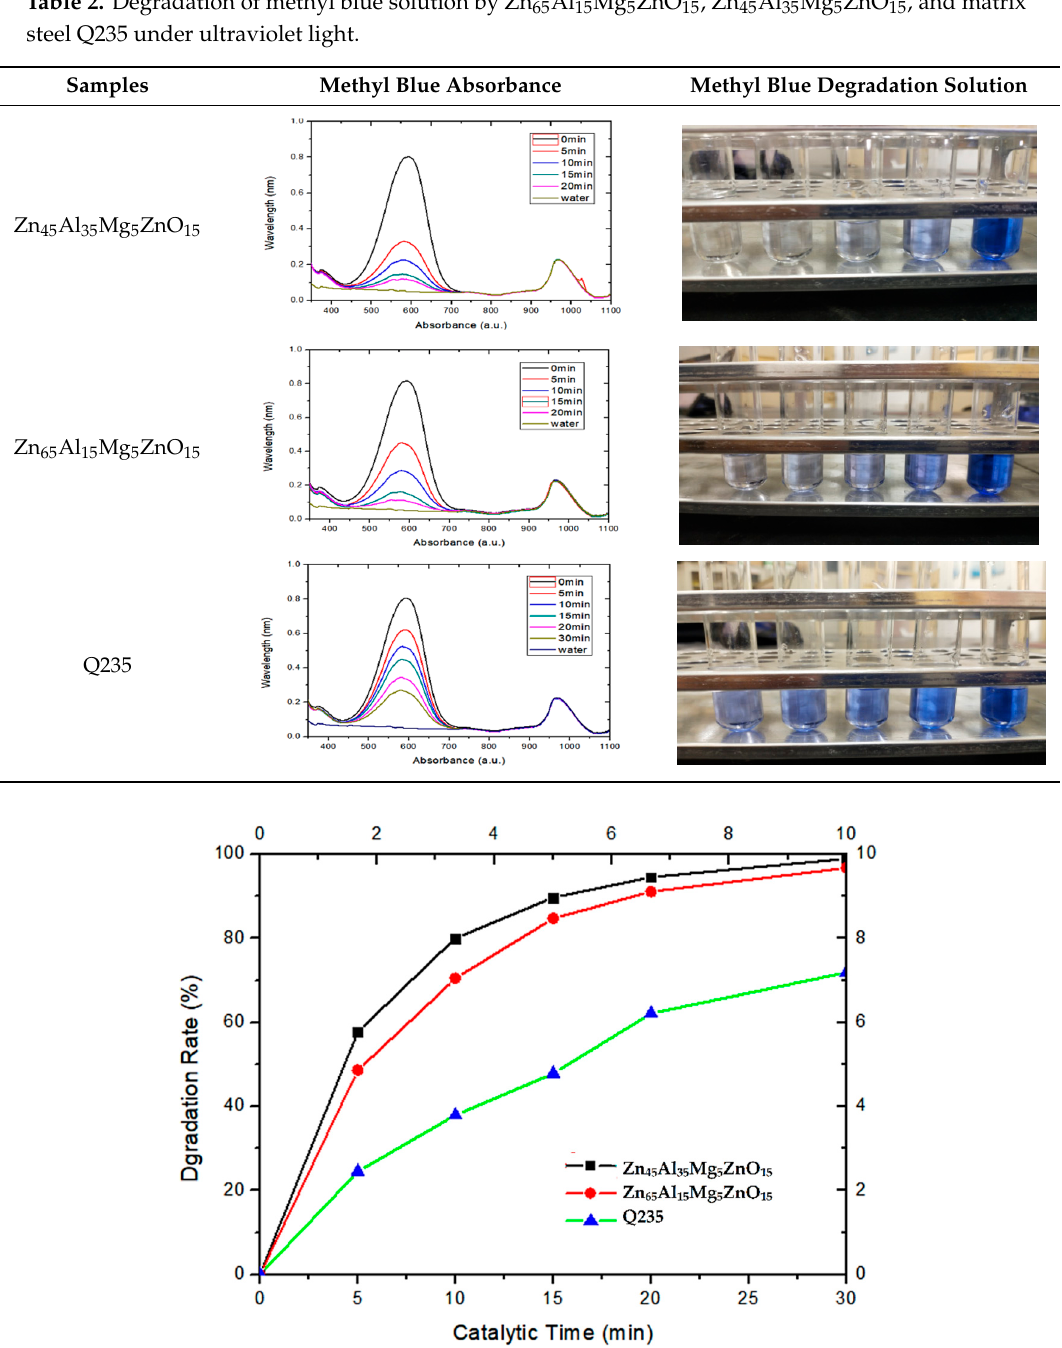
Figure 11. Degradation rate of equivalent concentration of methyl blue under ultraviolet light at di ff erent times for Zn 65 Al 15 Mg 5 ZnO 15 , Zn 45 Al 35 Mg 5 ZnO 15 , and base steel Q235. The methyl blue degradation test data show that the degradation rates of methyl blue by the Zn 65 Al 15 Mg 5 ZnO 15 composite coating and the Zn 45 Al 35 Mg 5 ZnO 15 composite coating were much faster than that of Q235 and that the coatings have good photocatalytic degradation. The degradation e ffi ciency of the Zn 45 Al 35 Mg 5 ZnO 15 composite coating on methyl blue is better than that of the Zn 65 Al 15 Mg 5 ZnO 15 composite